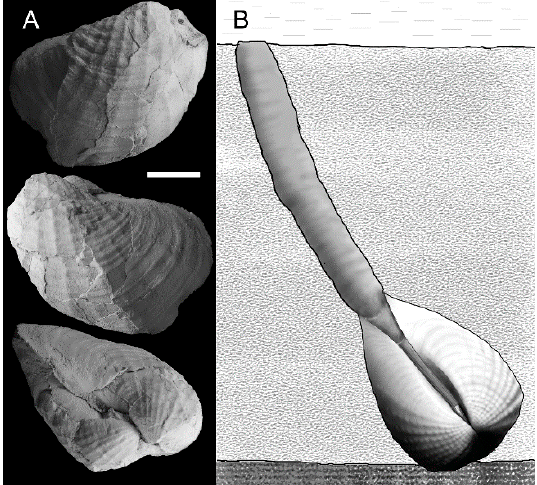
Figure 8. Deformation of the specimen from Blanowice preserved in a laterally inclined position, with a situational reconstruction.